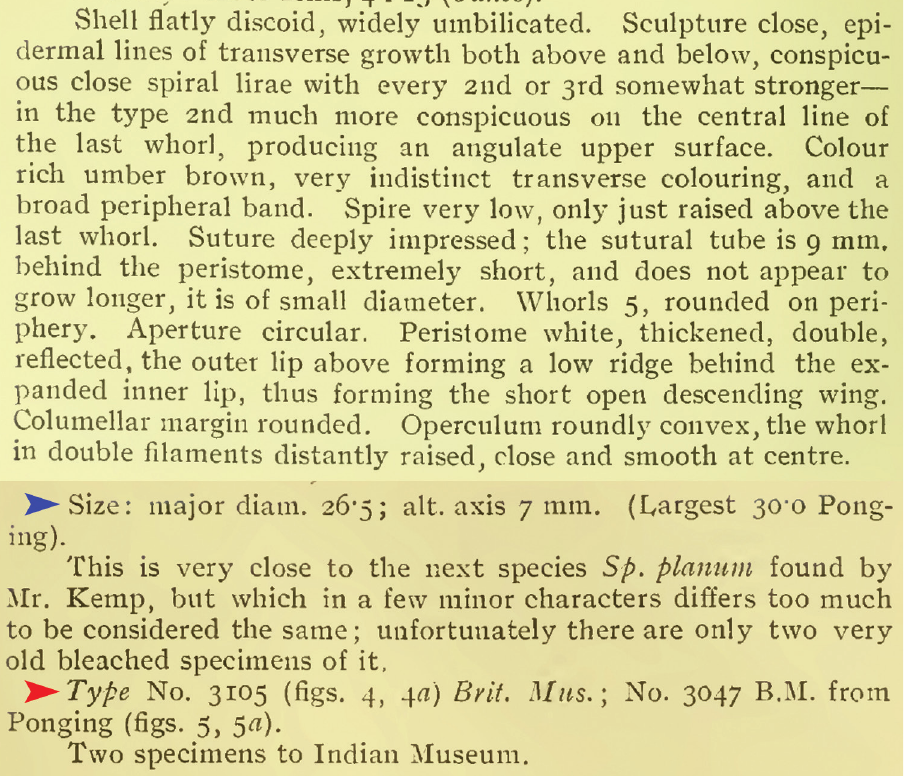
Figure 3. Original description of Spiraculum kempi from Godwin-Austen (1915). Red arrow indicates the annotation of “Type”. Blue arrow indicates the set of measurements. Credit: The Biodiversity Heritage